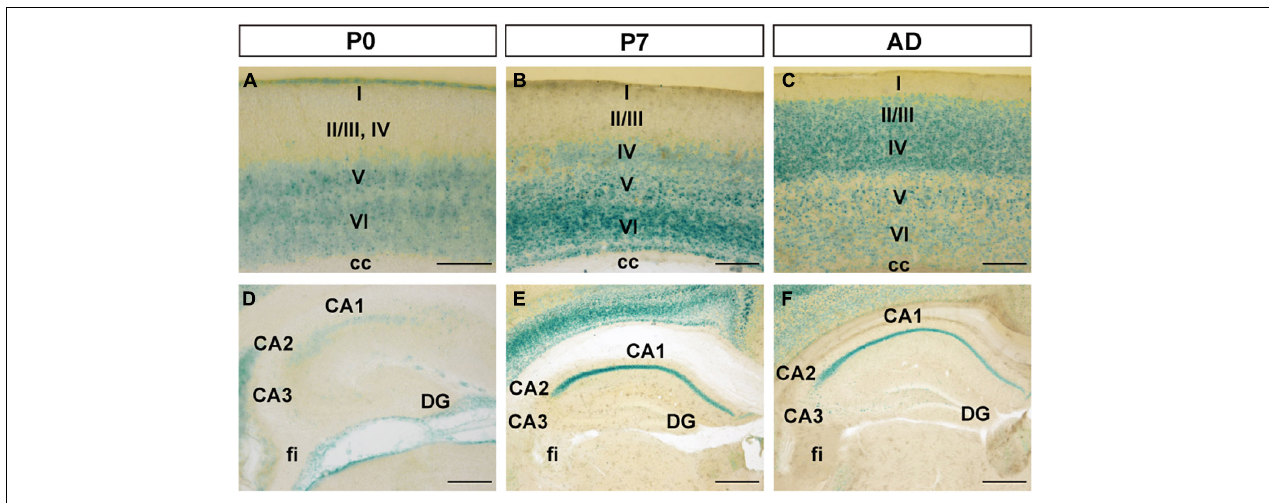
FIGURE 2 | FLRT2 expression in the cortical region (CTX) and during hippocampal formation (HPF) at P0, P7, and adulthood. (A–C) In the cerebral cortex, FLRT2 was expressed at deep layers at P0 (A) , followed by layer IV at P7 (B) and superficial layers II/III at adulthood (C) . (D–F) In the hippocampus, FLRT2 was expressed at a lower level in the CA1 at P0 (D) , becoming more intense at P7 (E) and adulthood (F) , concentrated in the pyramidal layer of CA1 but not CA2, CA3, or DG. cc, corpus callosum; CA1, Ammon’s horn field 1; CA2, Ammon’s horn field 2; CA3, Ammon’s horn field 3; DG, dentate gyrus; I–VI, layers of cortical region. Scale bars, 100 µ m (A) ; 200 µ m (B,C,D) ; 500 µ m (E,F) . n = 3, 3, and 4 for P0, P7 and adulthood,